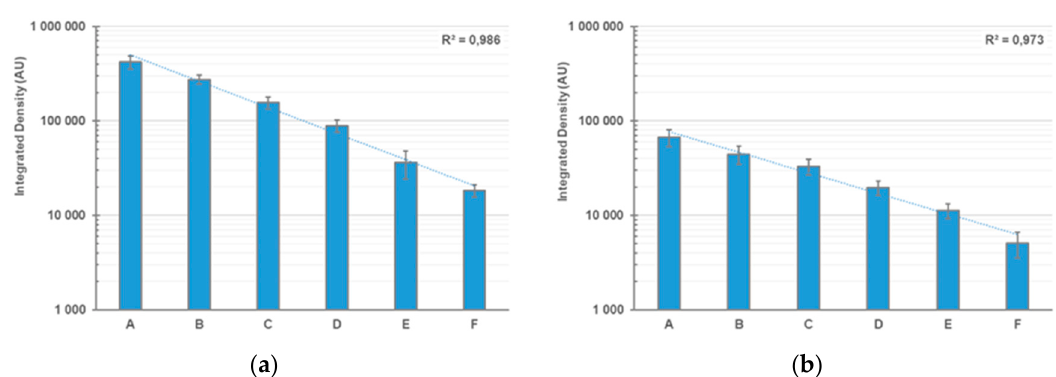
Figure 2. Densitometric analysis of zymography gels after using different staining methods. ( a ) Coomassie staining; ( b ) Ponceau staining. For sample description (FBS equivalents), see Table 1. Experiments were carried out as quadruplicates with four gels each for the Coomassie and Ponceau staining procedures. Data represent the mean of four independent experiments, error bars represent the respective standard deviation. Trendlines and the corresponding coefficients of determination (R squared) are shown; AU: arbitrary units of integrated density.